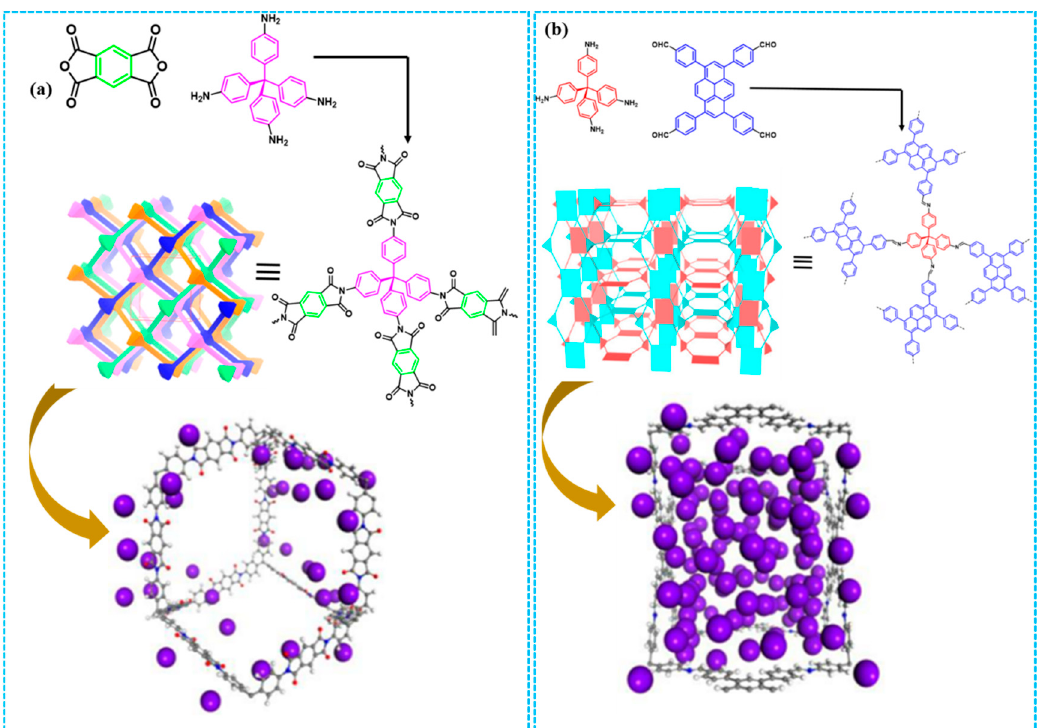
Figure 6. ( a ) Schematic representation of the synthesis and extended structure of PI-COF-5, and I 2 adsorption configurations in PI-COF-5. Reprinted/adapted with permission from Ref. [62]. Copyright (2015) American Chemical Society. ( b ) Schematic representation of the synthesis and extended structure of 3D-Py-COF, and I 2 adsorption configurations in the structure. Reprinted/adapted with permission from Ref. [63]. Copyright (2016) American Chemical Society.